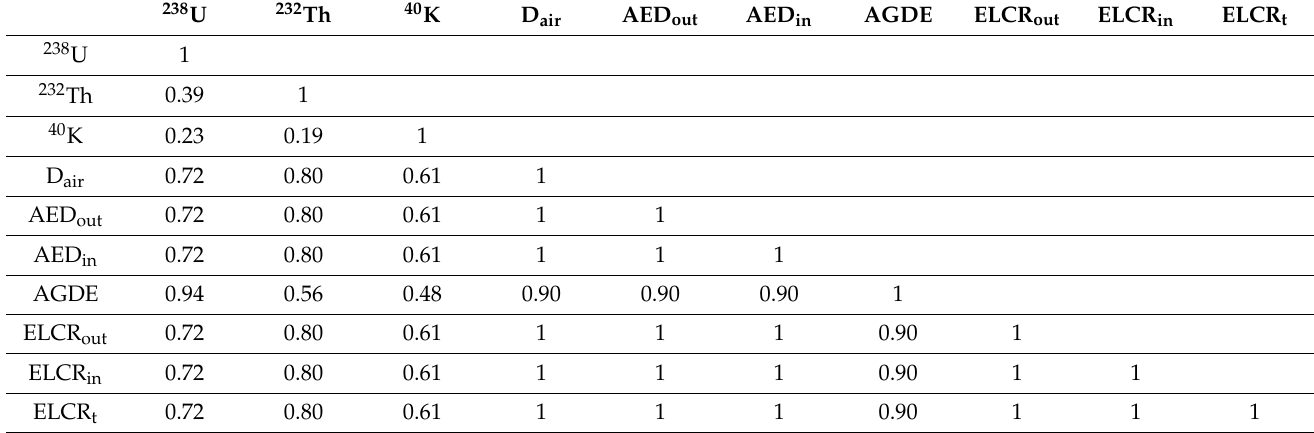
Table 6. The Pearson correlation matrix (PCM) of 238 U, 232 Th, 40 K activity concentrations and the radiological variables of alkali feldspar